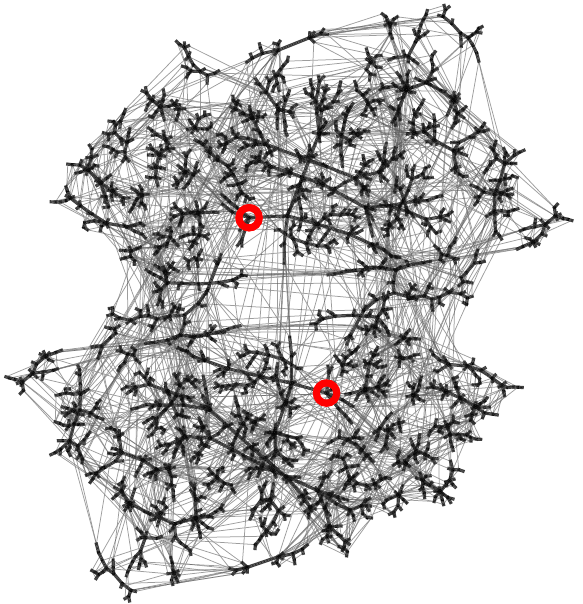
FIG. 4. Undirected kinetic network of the energy landscape of the strongly disordered ensemble illustrated in Fig. 1(c). The two degenerate ground states are indicated by the red circles. The thick black segments highlight the transitions that, starting from a given minimum, lead to a lower or equal energy involving the smallest energy barrier. Note that even the ground states do not qualify as hubs ( ρ c ¼ 10 − 3 )